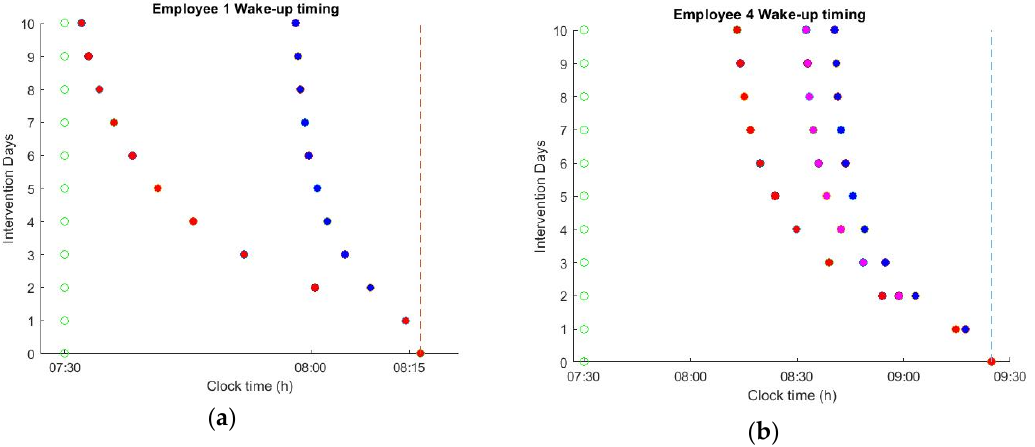
Figure 7. Predicted shift in wake-up times as a result of applying the updated lighting schedules.